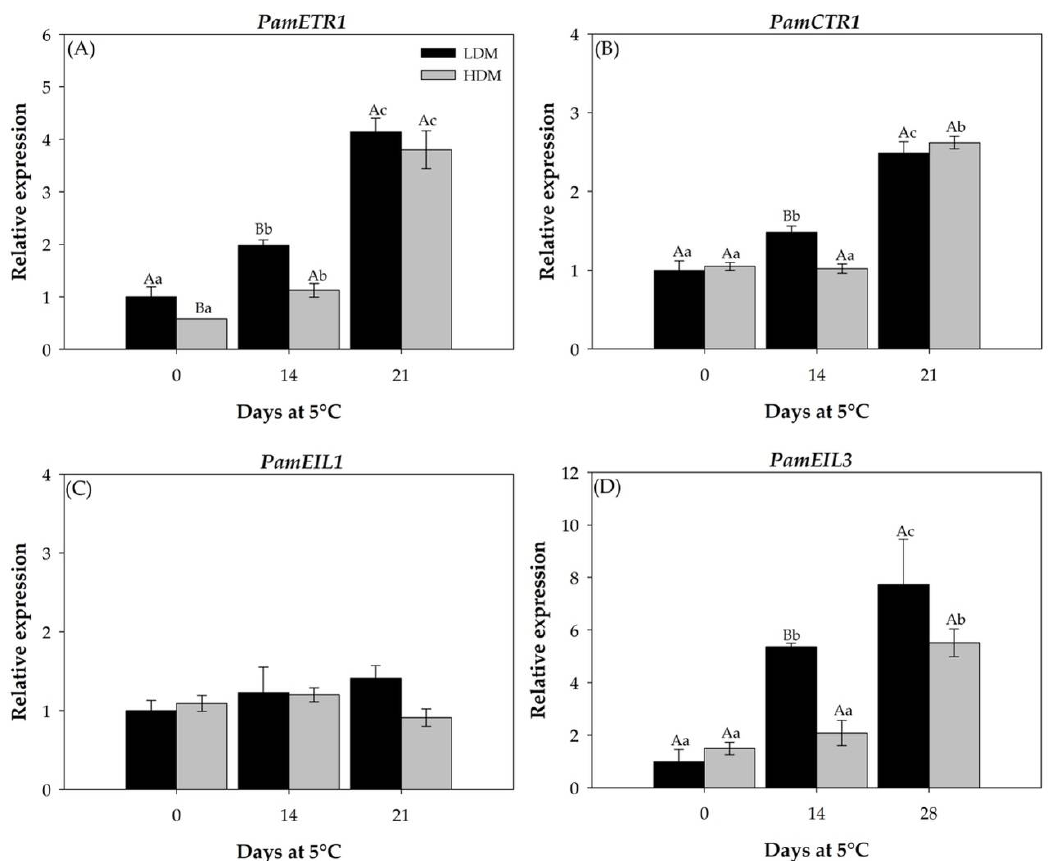
Figure 7. Relative expression analyses of genes from ethylene signaling pathway in “Hass” avocado before application of 1–MCP. ( A ) Relative expression of PamETR1 , ( B ) Relative expression of PamCTR1 . ( C ) Relative expression of PamEIL1 . ( D ) Relative expression of PamEIL3 . The transcript accumulation of genes was determined by qPCR. Expression was normalized to the housekeeping gene PamTCPB and the expression is relative to that in LDM fruit (day 0). Bars represent the means of three replicates ± SE. Different lowercase and capital letters indicate a significant difference among treatments and harvest times by LSD analysis ( p -value < 0.05).